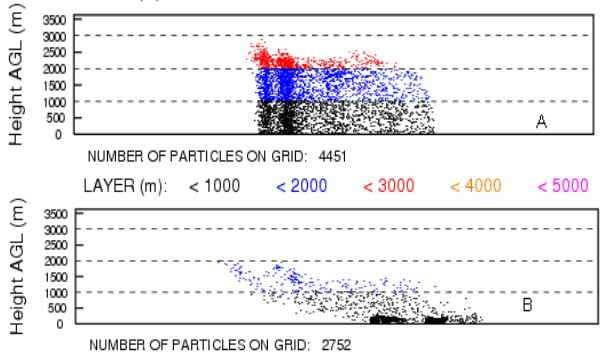
Figure 17 : Vertical section of particle positions simulated by the Hysplit model for continuous emissions from the four locations at a) 22 UTC 28 June and b) 10 UTC 29 June.